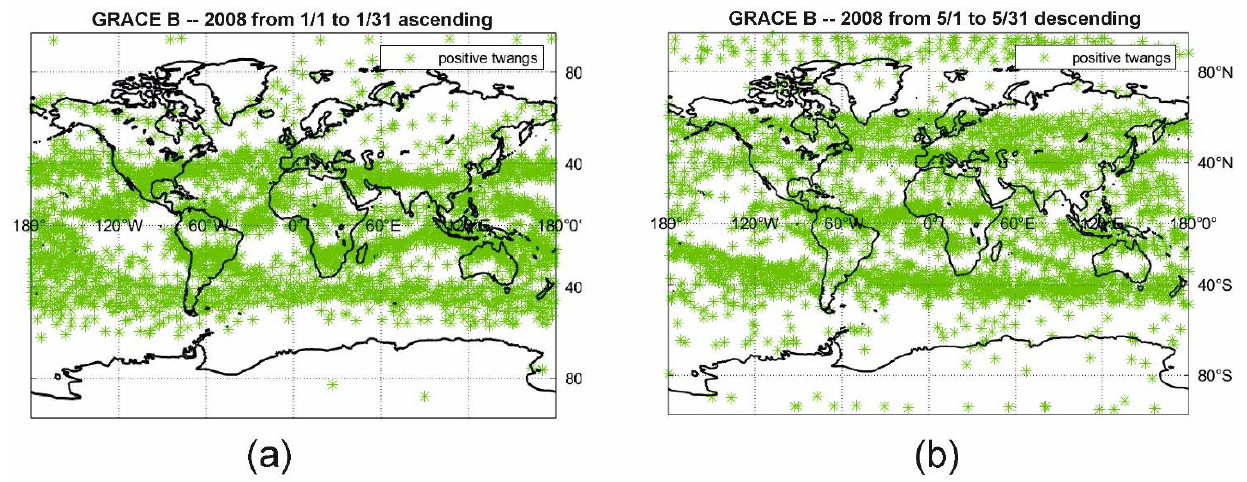
Figure 11. Summer ( b ) and winter ( a ) asymmetry of the occurrence of twangs on GRACE B in 2007/2008. The figure shows only positive twangs. The mid-latitude band of cloud-related twangs occurs in the winter between 60° S and 40° N and in the summer between 40° S and 60° N. The formation of whistlers depends on the magnetic field. The maximum numbers occur at latitudes of 40° to 60°. The maximum number of twangs is also located at these latitudes. We want to point out that Peterseim et al. [29] described a connection between the radial component of the magnetic field and the dependence on longitude of the northern mid-latitude band of twangs.